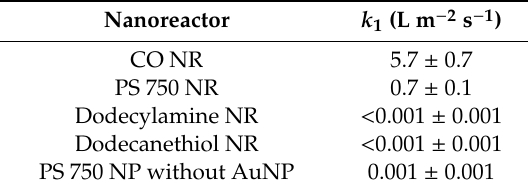
Table 4. Reaction kinetics of di ff erent polymer nanoreactors at 1.0-M NaBH 4, 0.1-mM